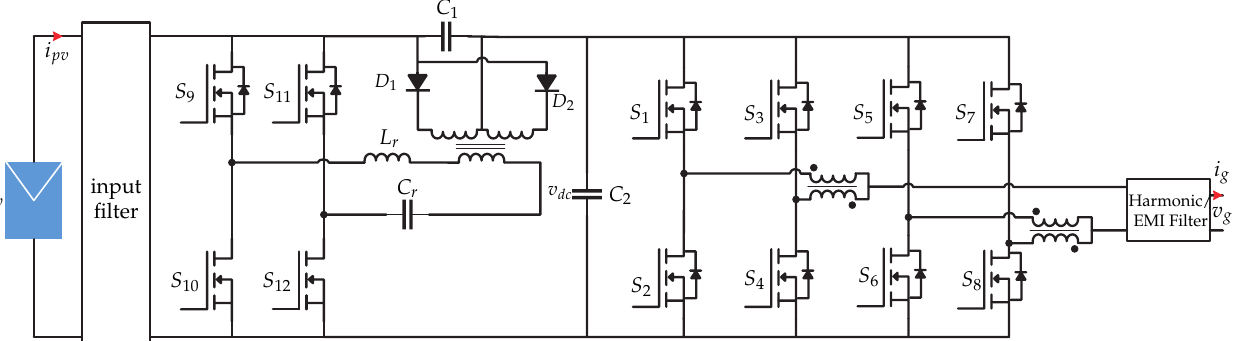
Figure 26. Microinverter’s topology proposed in [64].